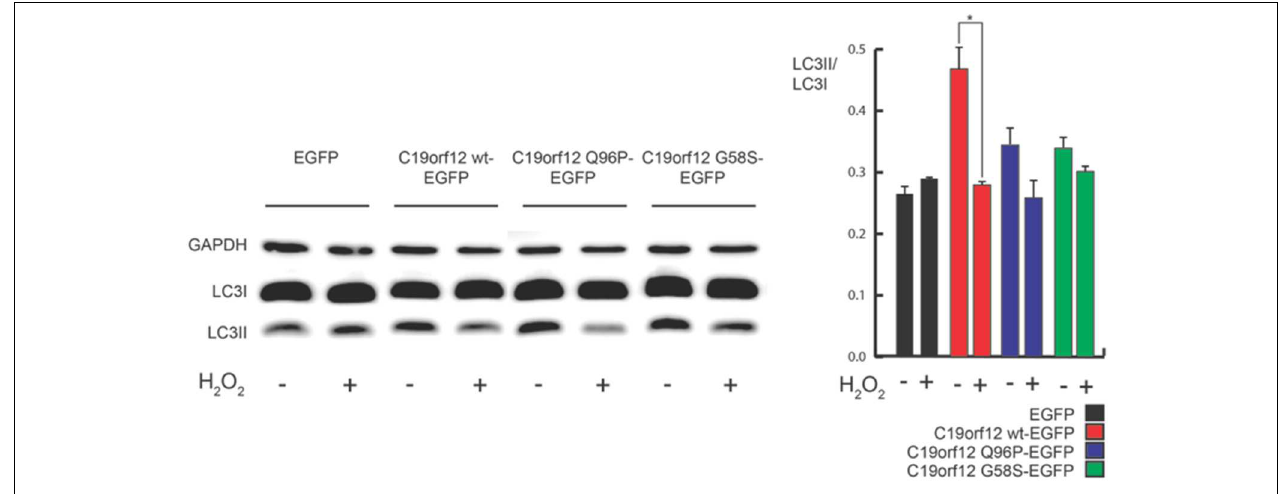
FIGURE 9 | Analysis of autophagy during C19orf12-EGFP wild-type and mutants overexpression. Representative western blot analysis of autophagic marker LC3 in HeLa cells overexpressing C19orf12-EGFP, C19orf12 G58S-EGFP, C19orf12 Q96P-EGFP, or EGFP empty vector as